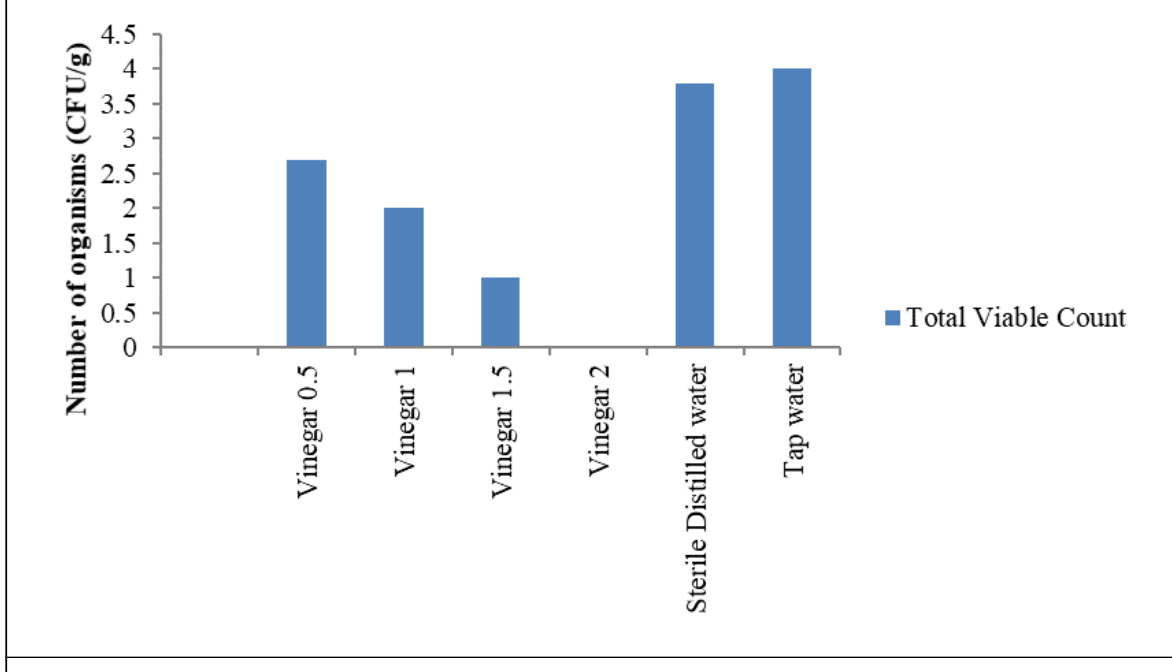
Table 1: Effect of concentration and exposure time of vinegar on lettuce sample